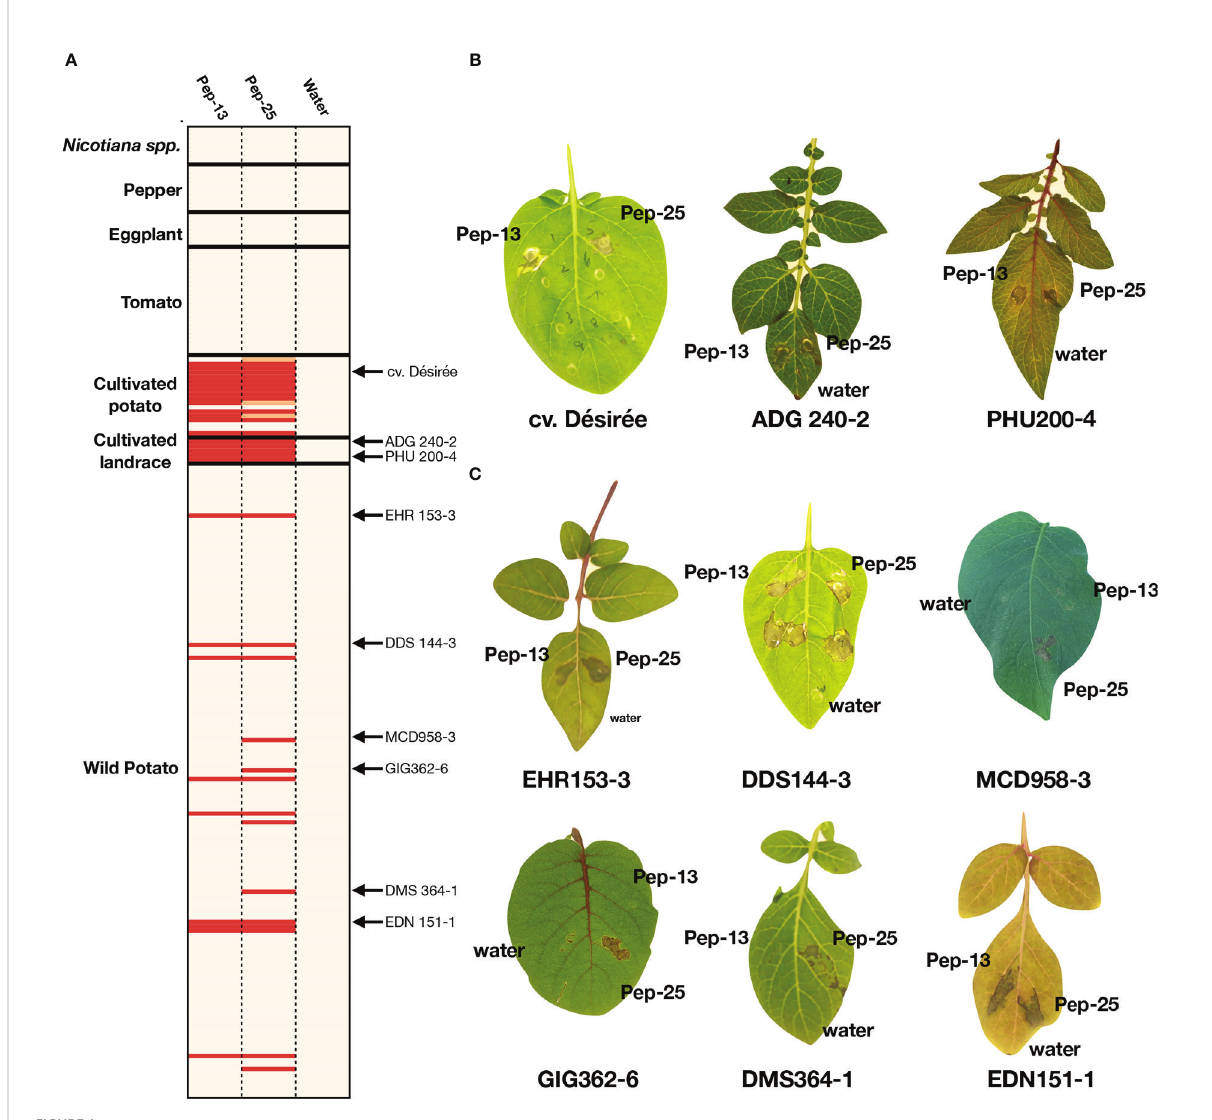
FIGURE 1 Screening for Pep-13/25 recognition in multiple Solanaceae species (A) . Heatmap of Pep-13 and Pep-25 recognition in different Solanaceae species and genotypes. The HR severity was scored. Strong HRs after Pep-13/25 in fi ltration are highlighted by red, weak HRs are highlighted by orange, beige indicates no HR. The genotypes with arrows are shown in (B, C) . The detailed scoring table is shown in Supplementary Table 1. (B) . Examples of Pep-13/25 recognition in cultivated potatoes and landraces. Solanum tuberosum Group tuberosum cv De ́ sire ́ e, S. tuberosum Group andigena (ADG 240-2) and S. phureja (PHU200-4) respond to both Pep-13 and Pep-25. (C) Examples of Pep-13/25 recognition in wild Solanum spp. Genotypes of S. ehrenbergii (EHR), S. doddsii (DDS), S. microdontum (MCD), S. microdontum subsp. gigantophyllum (GIG), S. demissum (DMS) and S. edinense (EDN) are shown. EHR153-3, DDS144-3 and EDN151-1 respond to both Pep-13 and Pep-25, but MCD958-3, GIG362-6, DMS364-1 respond only to